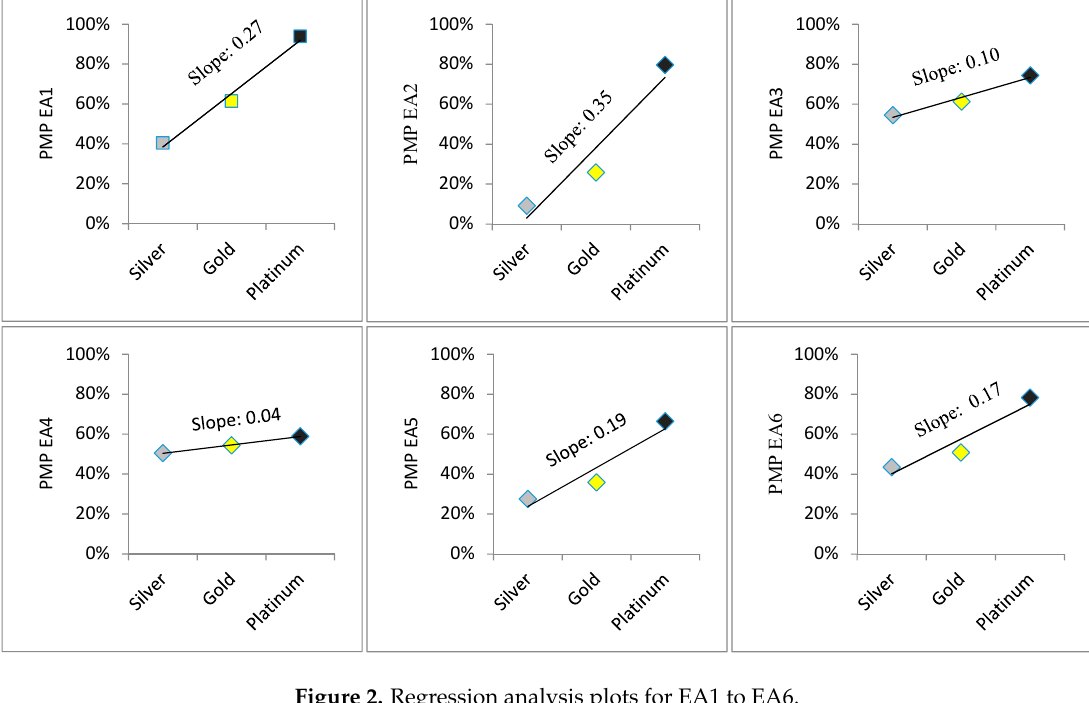
Figure 2. Regression analysis plots for EA1 to EA6.